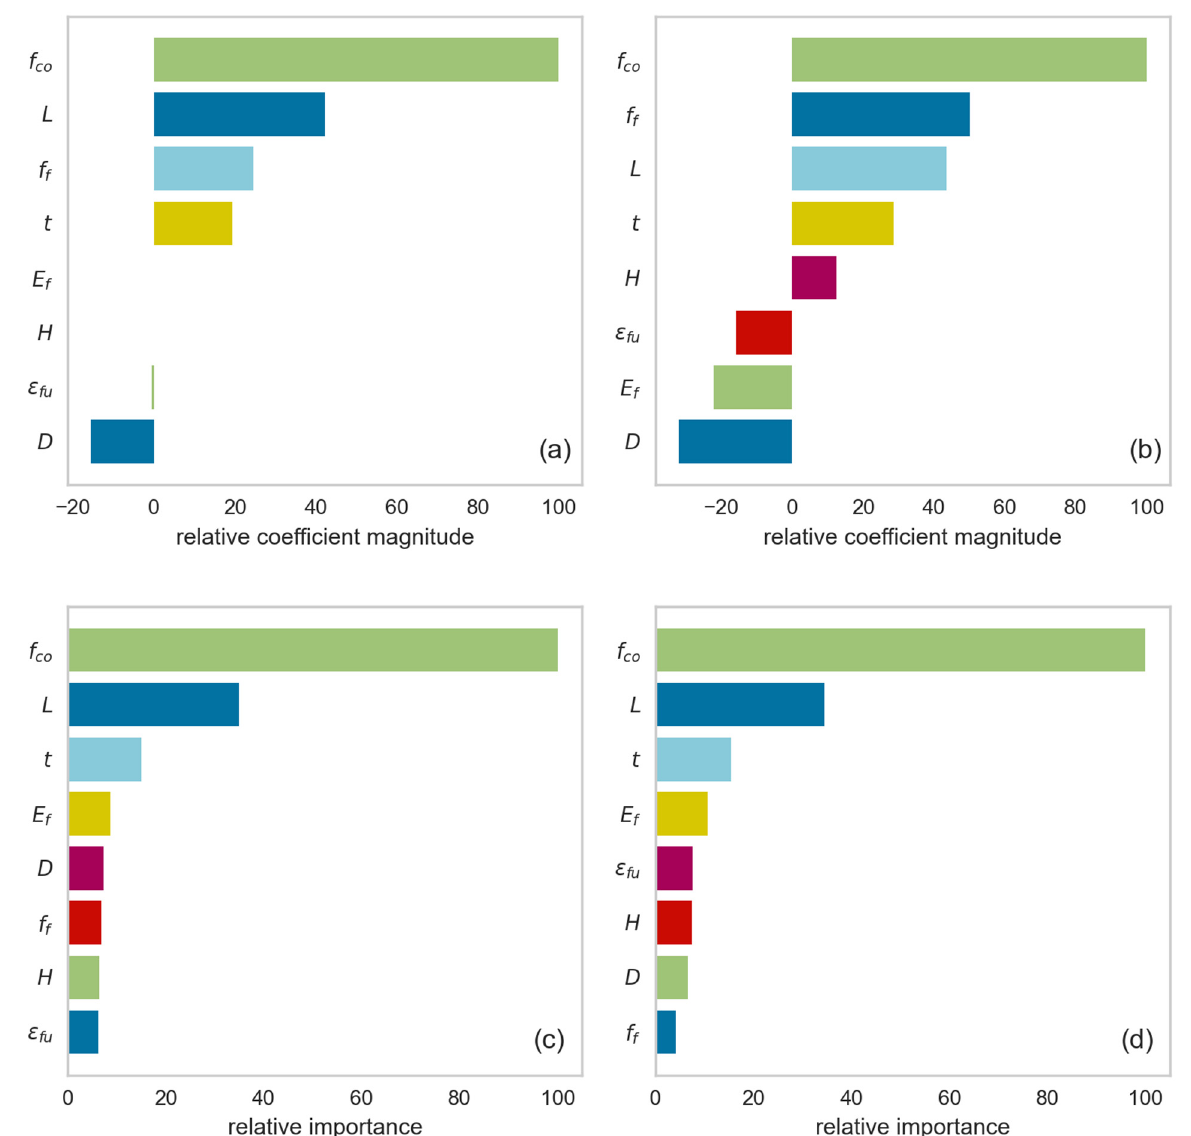
Figure 7. Feature importance for the ( a ) LASSO, ( b ) Ridge, ( c ) RF, and ( d ) GBR algorithms.